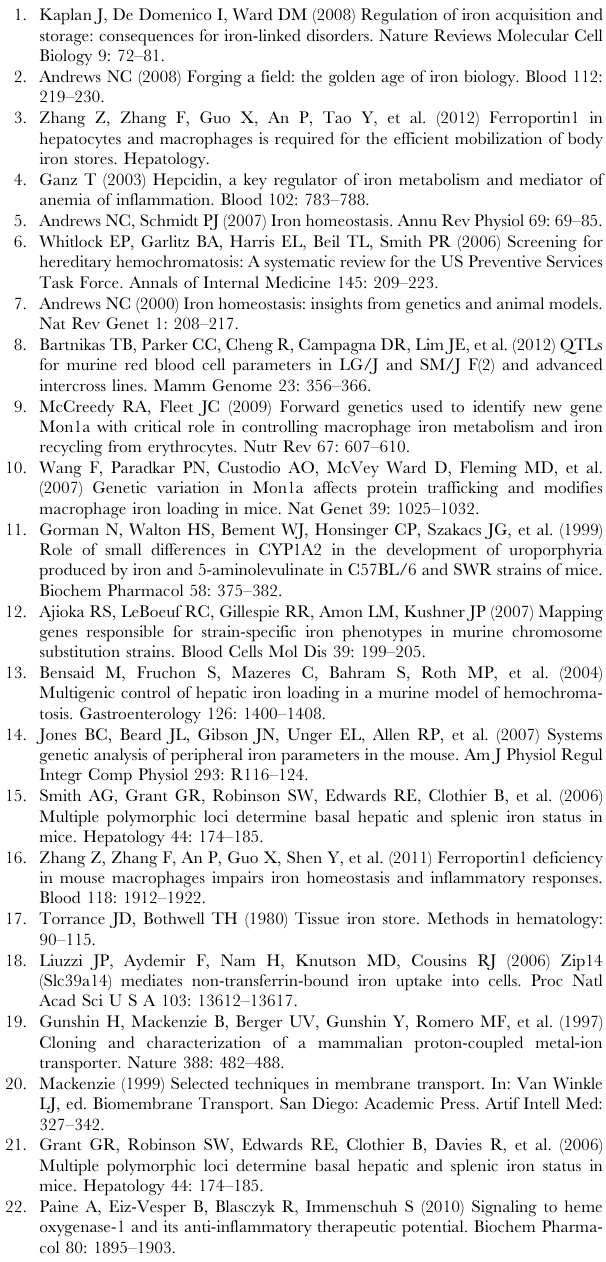
Figure S6 Relative mRNA expression of iron related genes in mouse liver overexpressed the indicated candidate genes through hydrodynamic transfection. n =5 male mice for each group, b -actin was used as an internal control and data was represent as ratios of pLIVE control relative to candidate genes group. Data represent mean 6 SEM, N.S: no significance. Table S1 Sequences of genotyping primers. Table S2 Sequences of oligonucleotide primers for Real-time PCR.